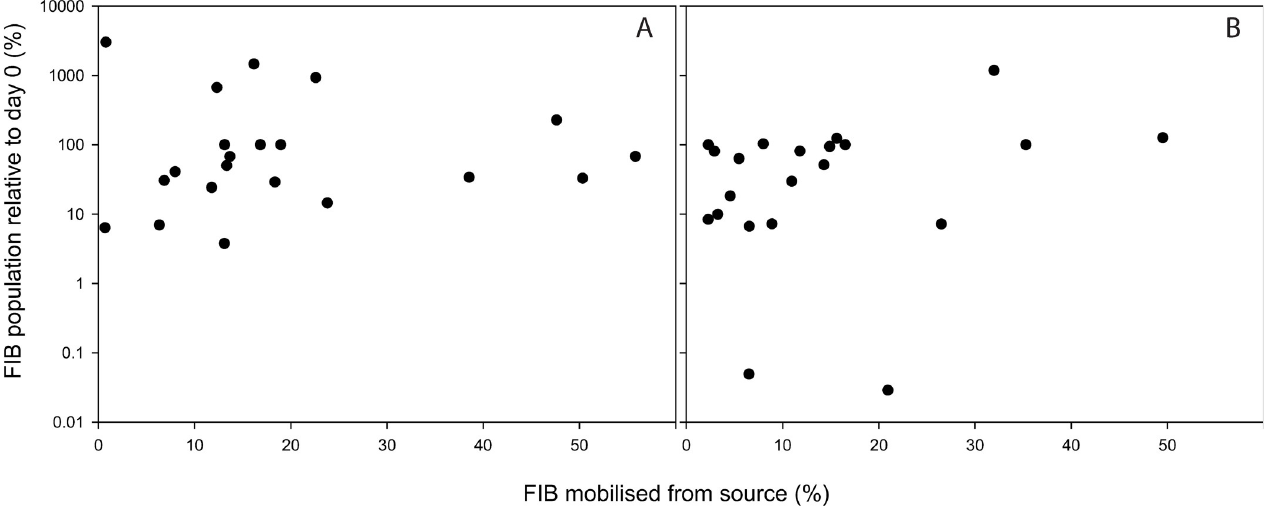
Fig 4. The proportion of E . coli (A) and intestinal enterococci (B) mobilised as a function of the FIB source load for all three faecal sources combined (normalised to reflect the FIB population relative to day 0.